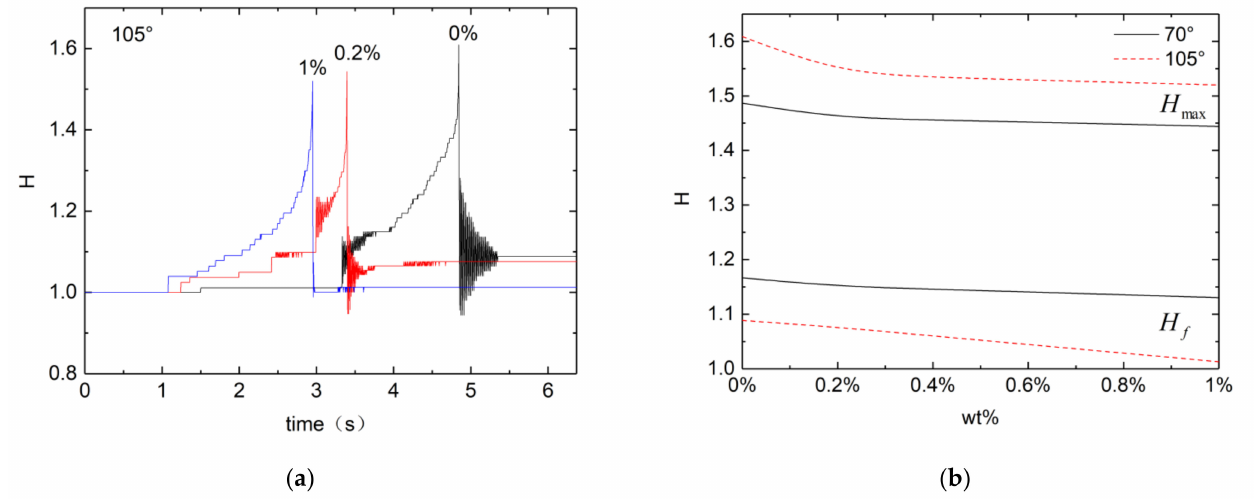
Figure 4. Droplet deformation on a dielectric PDMS substrate with contact angle 105 ◦ . ( a ) Droplet height against time; and ( b ) equilibrium height against PEO